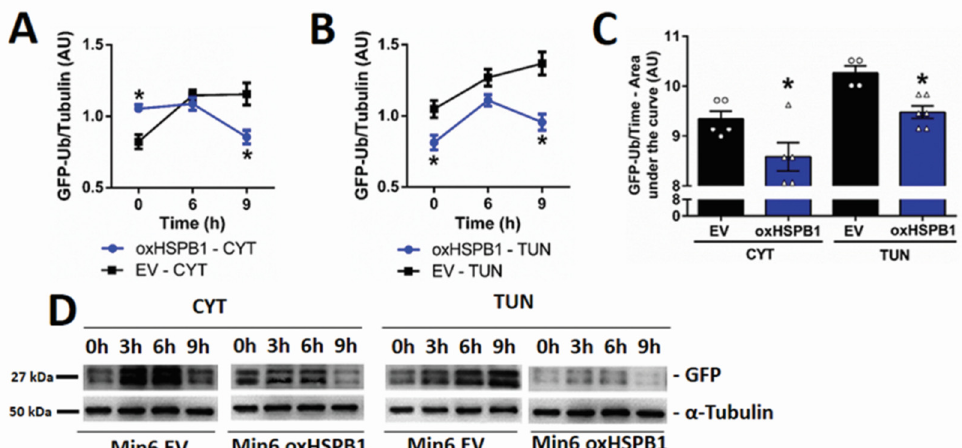
Figure 5. HSPB1 overexpression accelerates the rate of protein degradation by decreasing the levels of ubiquitinated proteins in Min6 cells submitted to ER stress. Min6 OX and Min6 EV cells were transfected with the GFP-Ub vector and were then exposed to a combination of proinflammatory cytokines (TNF- α 8 ng/mL, IFN- γ 16 ng/mL, IL-1 β 1.6 ng/mL) or tunicamycin (15 µ g/mL). GFP levels were analyzed in total protein extracts obtained after 6 and 9 h of treatment and analyzed by Western blot assays. Quantification of the GFP levels presented as arbitrary densitometric units (AU) after normalization to the corresponding α -tubulin content in cells treated with ( A ) cytokines or ( B ) tunicamycin. ( C ) Histogram representation of the area under the GFP level curves of the different cell types submitted to ER stressors for 9 h. ( D ) Repre- sentative images of the immunoblots showing GFP expression in Min6 cells treated with cytokines or tunicamycin. Each data point represents the mean ± SEM from three replicates and at least three independent experiments carried out for each cell type submitted to the different cell incubation conditions; * p <0.05 vs. EV.